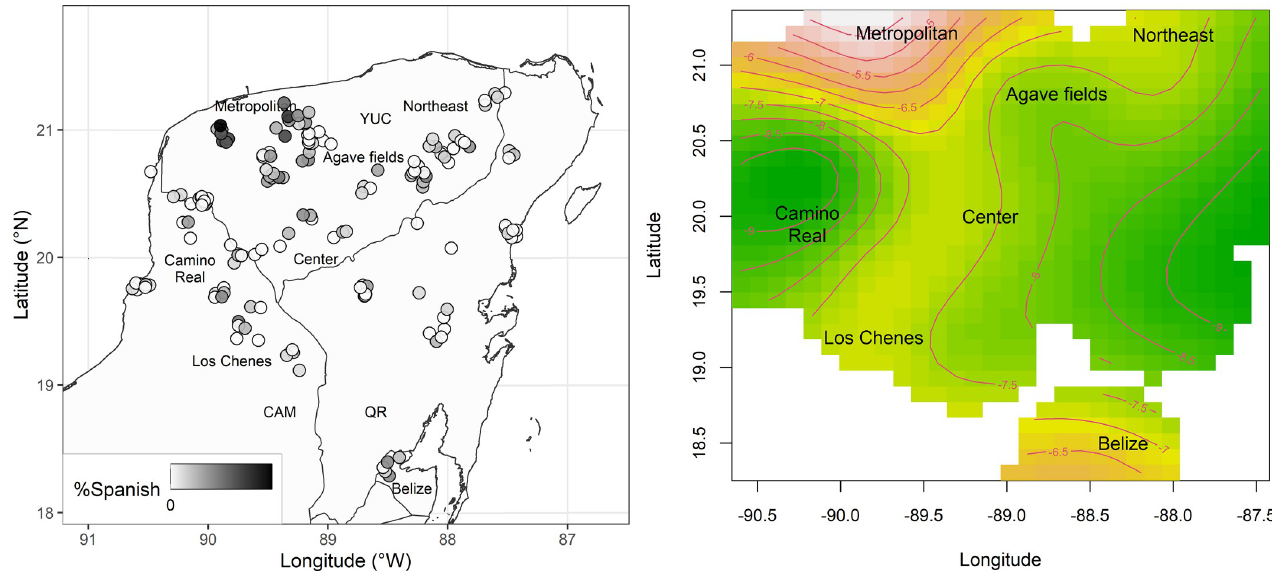
Fig 10. Distribution of Spanish variants in space. (A) Average Spanish variants per speaker. (B) Contour plot of S PACE coefficients (estimates of the smooth term in GAM).